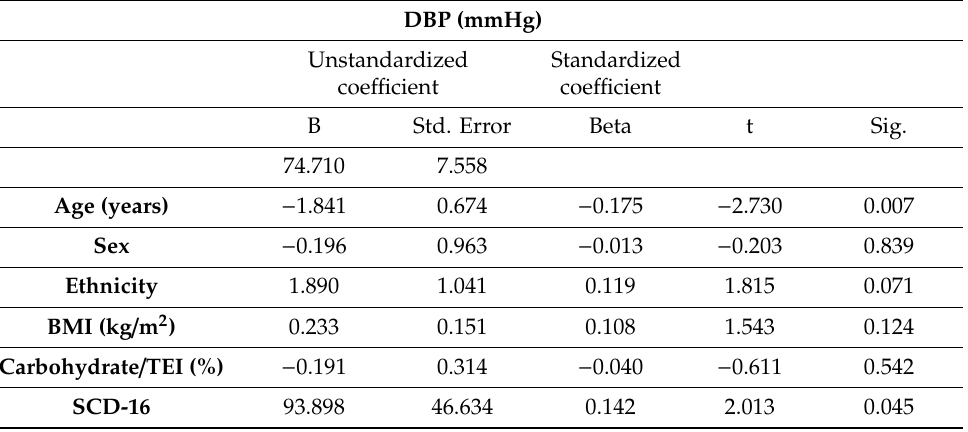
Table 3. Linear regression model for